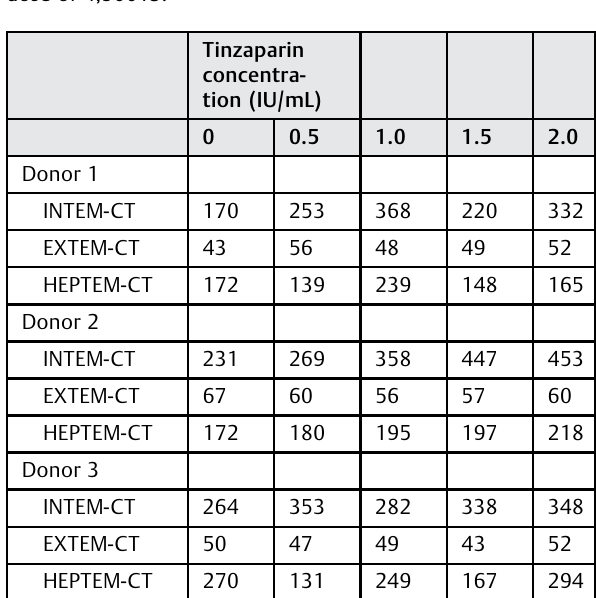
Table 5 INTEM-/EXTEM-/HEPTEM-CT at different tinzaparin concentrations, where 1.0 IU/mL corresponds to a tinzaparin dose of 4,500 IU.